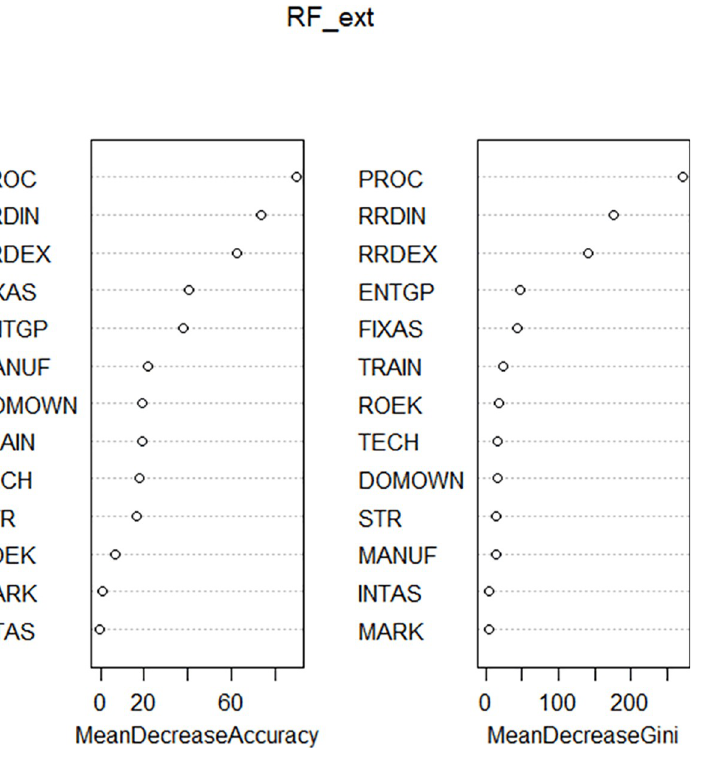
Fig 6. Importance of selected innovation determinants–Model